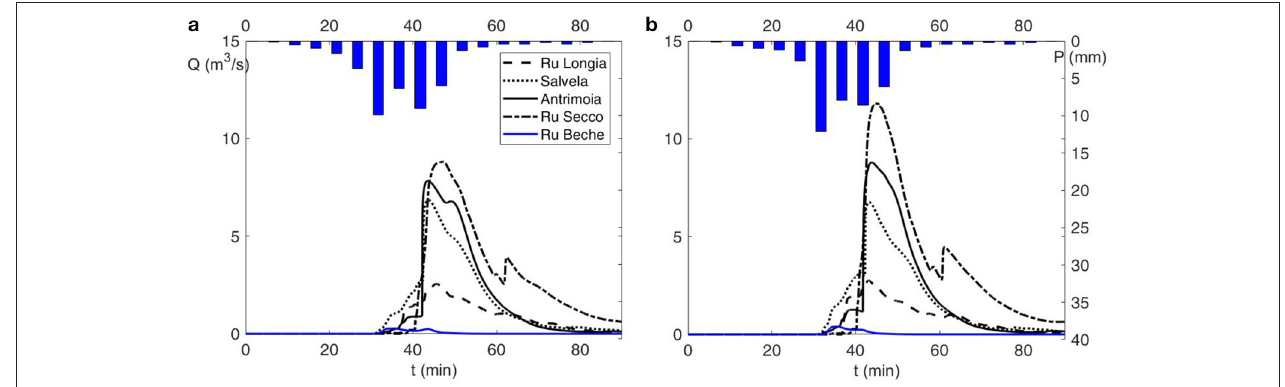
FIGURE 10 | Modeled runoff hydrographs for the five basins corresponding to the measures (a) and corrected radar estimates (b) of rainfall depth.